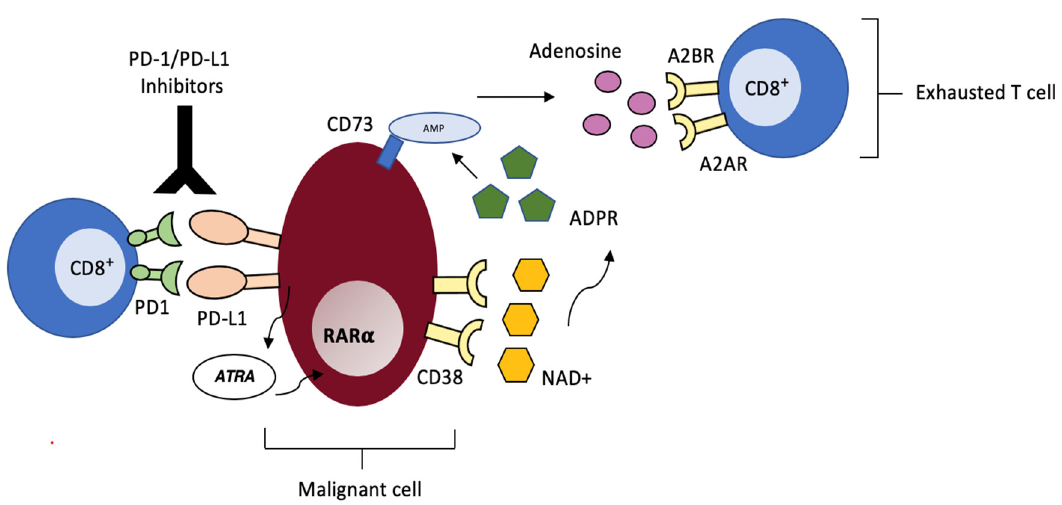
Figure 2. CD38-mediated acquired resistance to PD-1 / PD-L1 Inhibitors. Malignant cells resistant to checkpoint inhibition produce mediators such as ATR that lead to CD38 up-regulation via RAR α . CD38 catalyzes the conversion of NAD + into immunosuppressive adenosine via the CD38 / CD203a / CD73 ectoenzymatic pathway. Adenosine interacts with A2AR and A2BR adenosine receptors on CD8 + T cells, thus suppressing cytotoxic activity.